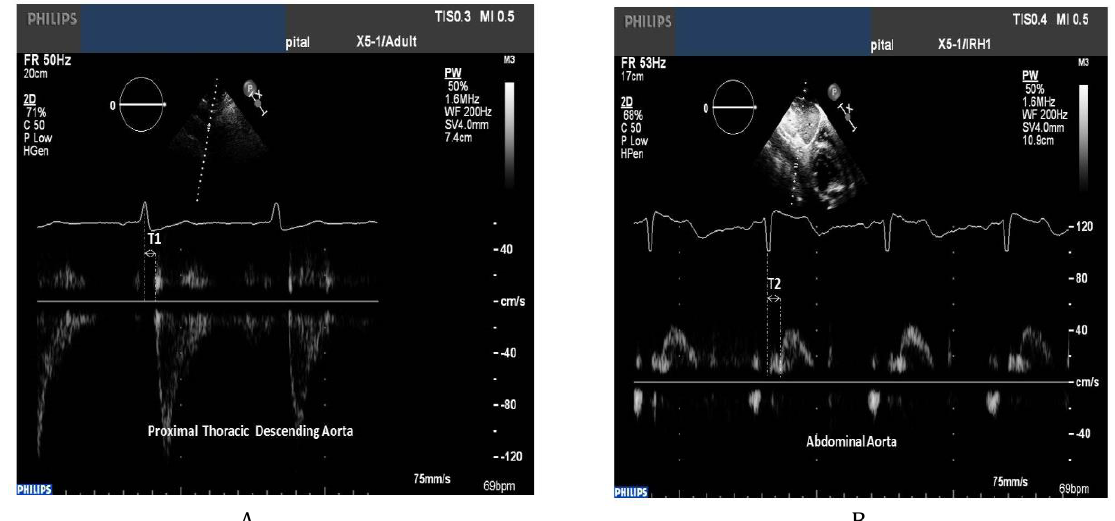
A B Figure 1. Pulsed Doppler signals, taken from proximal part of thoracic descending aorta (A) and abdominal aorta (B) to measure the time interval between R wave in electrocardiogram and the initiation of systolic signal